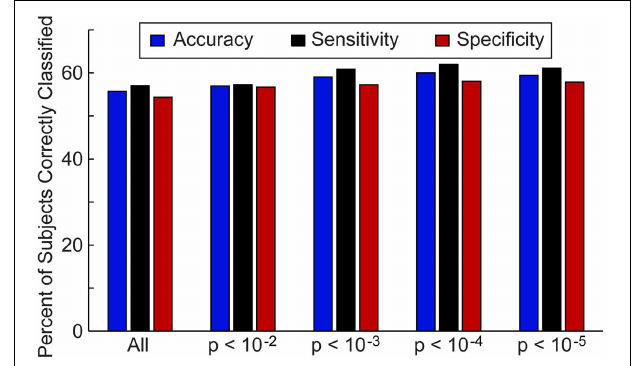
FIGURE 2 | Total accuracy, sensitivity, and specificity for leave-one-out classifier in 964 subjects. The total accuracy, sensitivity, and specificity are shown when all 26.4 million connections were included in the classifier and then for different p -value thresholds that determine which connections are included in the